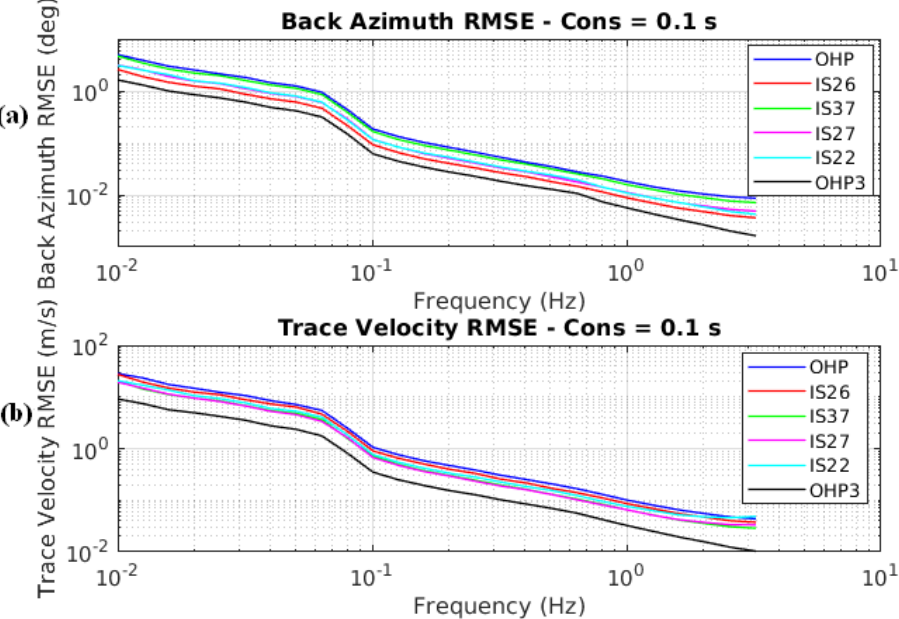
Figure 17. Plots (log-scales) of the ( a ) back azimuth and ( b ) trace velocity RMSE as functions of frequency. The OHP station is blue, IS22 is cyan, IS26 is red, IS37 is green, IS27 is magenta, and OHP3 is